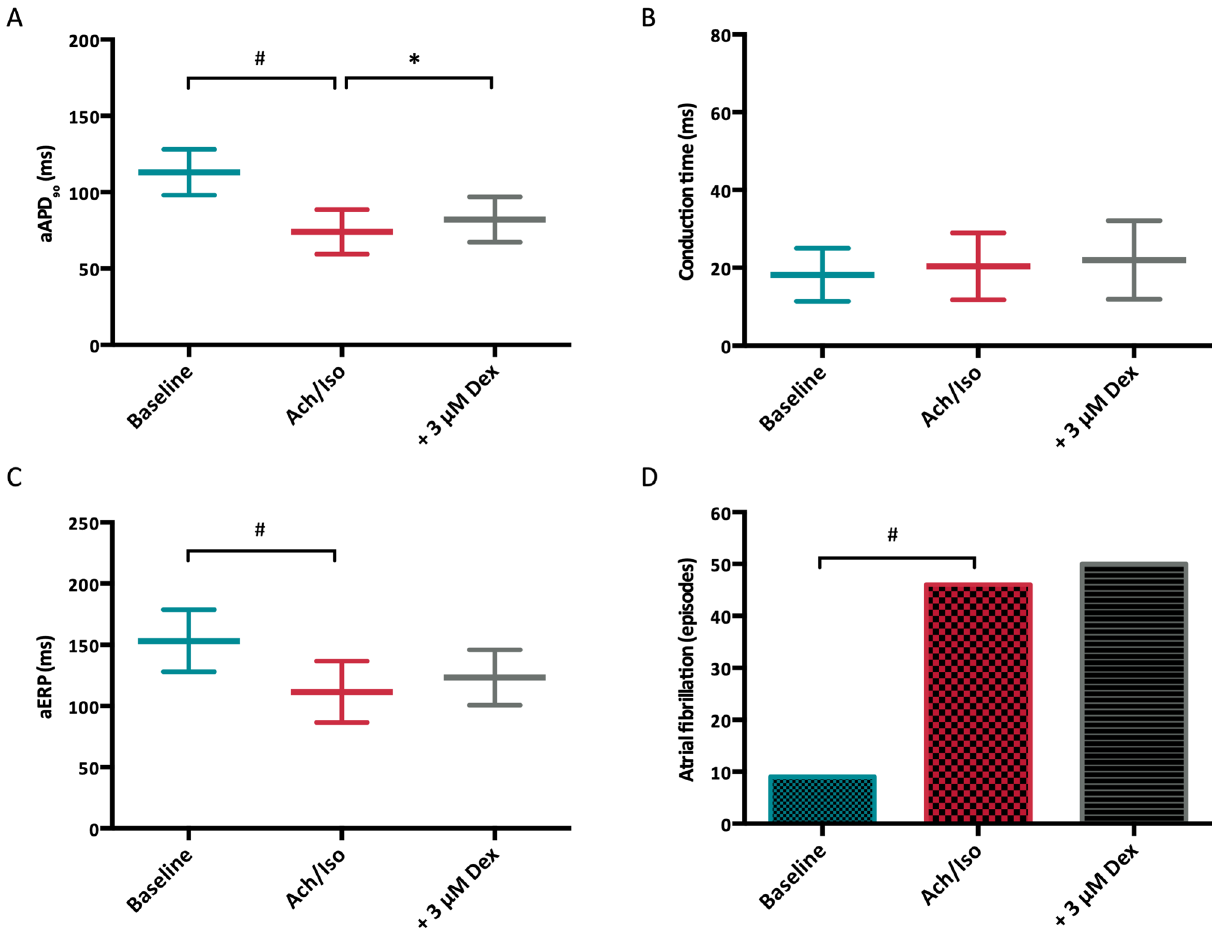
Figure 7. ( A ) Impact of acetylcholine (Ach)/ isoproterenol (Iso) and dexmedetomidine (Dex) on atrial APD 90 (aAPD 90 ). ( B ) Effect of Ach/Iso and dexmedetomidine on atrial conduction time. ( C ) Influence of Ach/Iso and dexmedetomidine on atrial effective refractory periods (aERP). ( D ) Incidence of atrial fibrillation episodes under baseline conditions, with Ach/Iso and with additional dexmedetomidine, respectively (# = p < 0.05 compared to baseline conditions; * = p < 0.05 compared to sole Ach/Iso